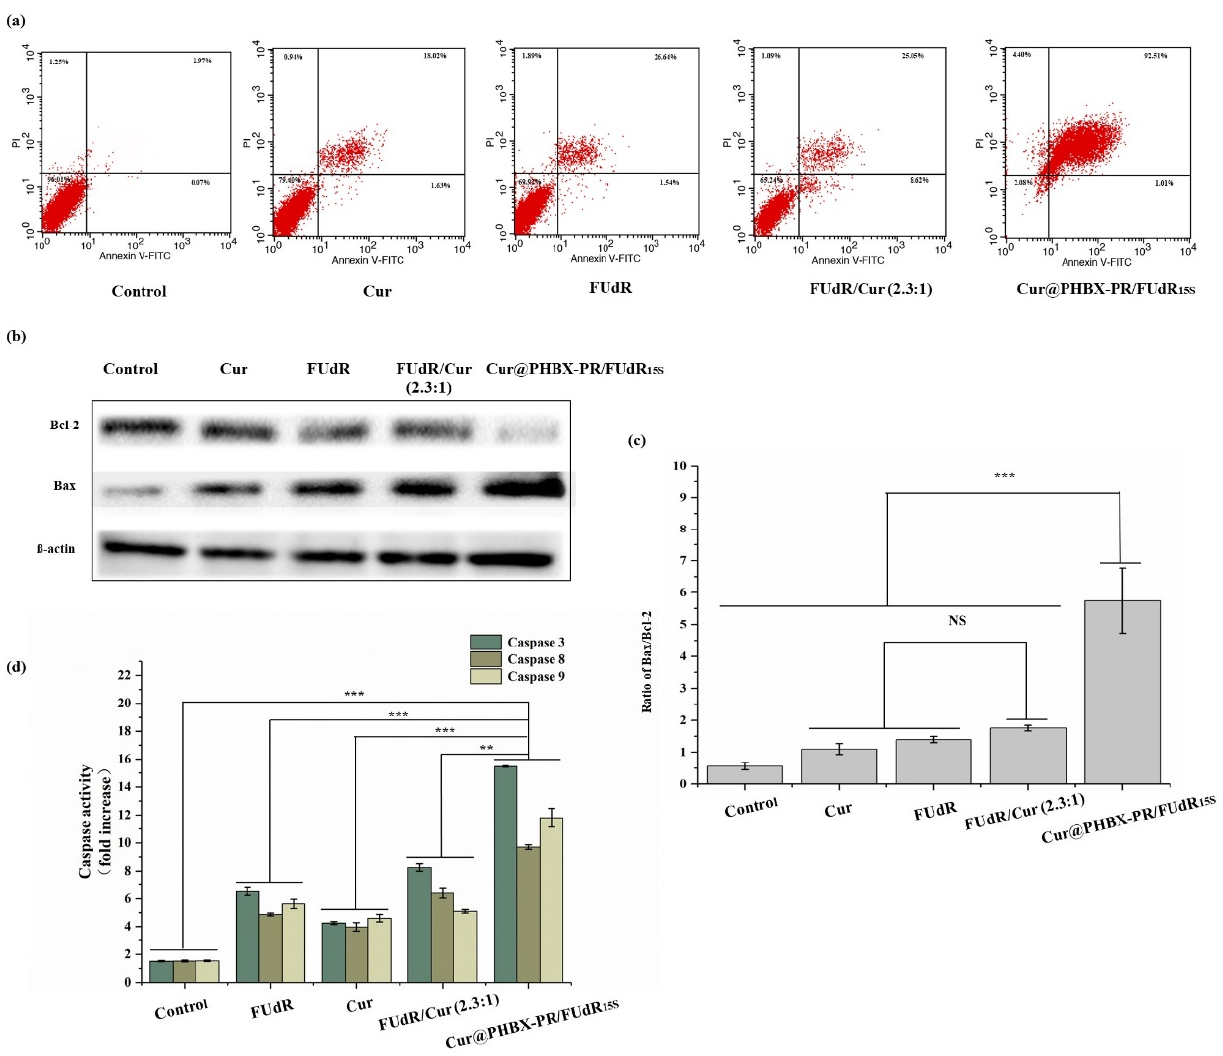
Figure 7. Expression and activity detection of apoptosis-related proteins. ( a ) Cell apoptosis assay using flow cytometry. ( b ) Bcl-2 and Bax protein expression in MGC 803 cells treated with free Cur, FUdR, FUdR/Cur (2.3:1), and Cur@PHBX-PR/FUdR 15S . ( c ) Ratio of Bax/Bcl-2 in MGC 803 cells. ( d ) The activity of caspase 3, 8, and 9 in MGC 803 cells treated with free Cur, FUdR, FUdR/Cur (2.3:1), and Cur@PHBX-PR/FUdR 15S (No significant difference (NS), ** p < 0.01 and *** p < 0.001).